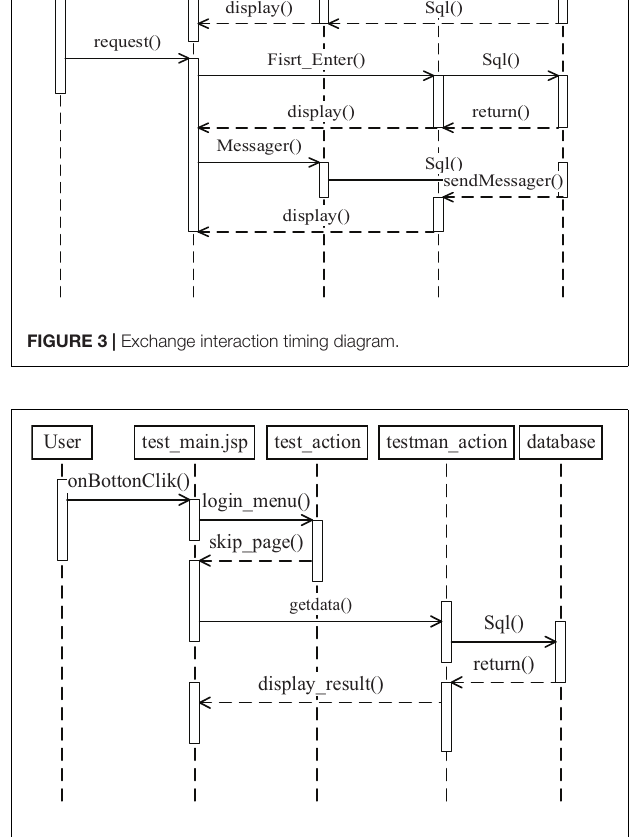
FIGURE 4 | Result query function timing chart.